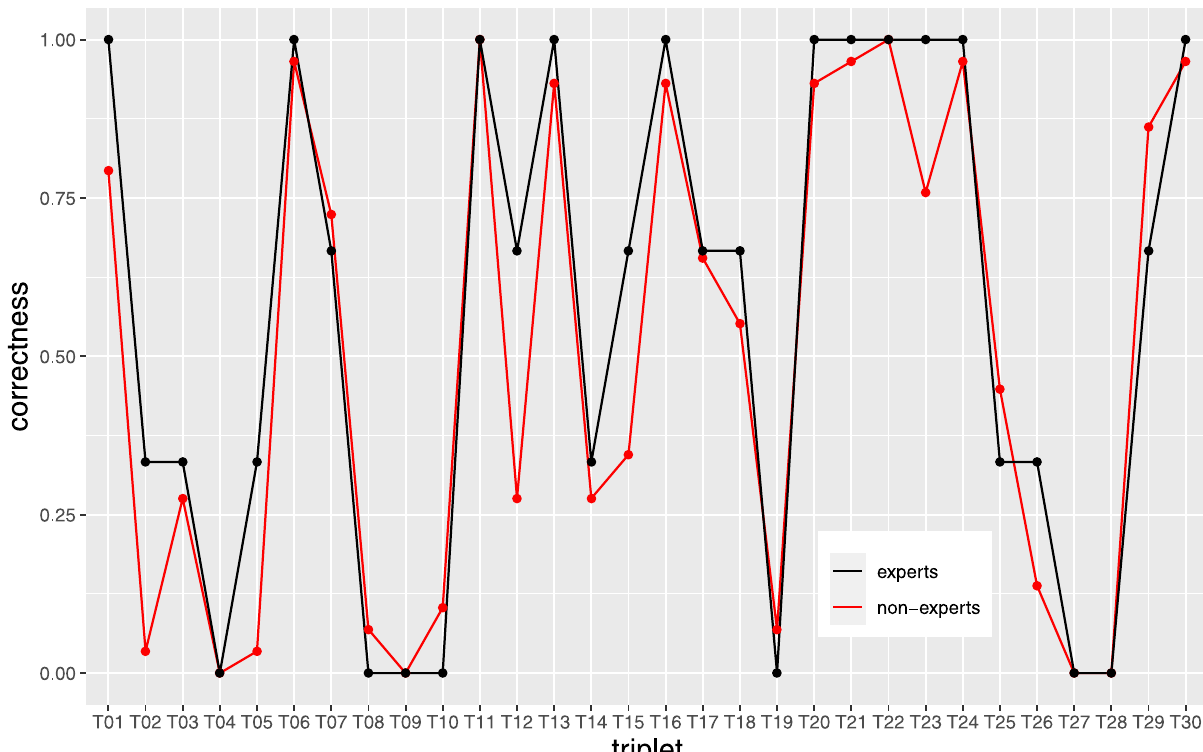
Fig 4. T_CorrectnessRatio for the experts (black line) and for the annotators (red line). The two groups performed similarly, and misclassified some triplets in agreement; slight differences can be explained by the large difference between the number of non-experts (29) and the number of experts (3).